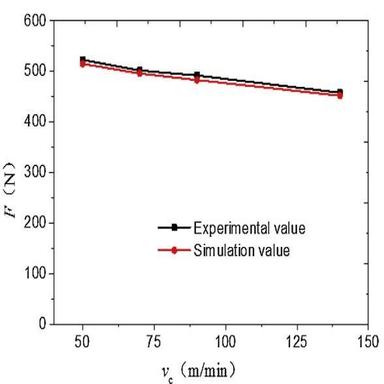
Variation of cutting force F with cutting speed vc. (a) L- vc curve (b) f x vc curve.